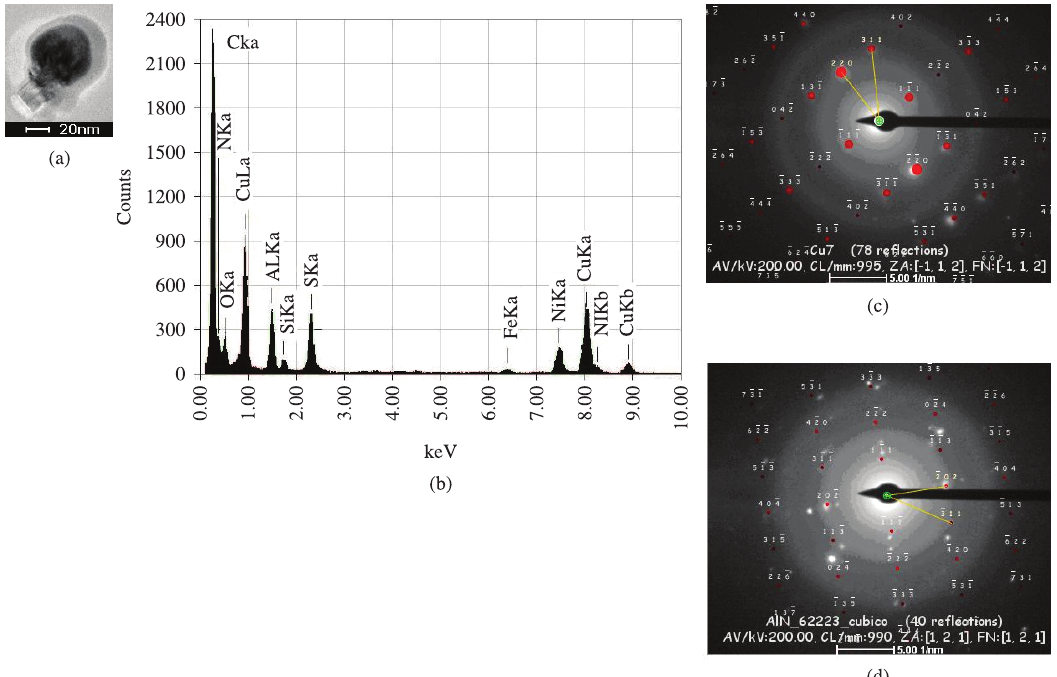
Figure 3. Micrograph of Cu S+AlN precipitate (a), EDS spectrum (b) and diffraction pattern ((c) and (d)) for the sample performed at x